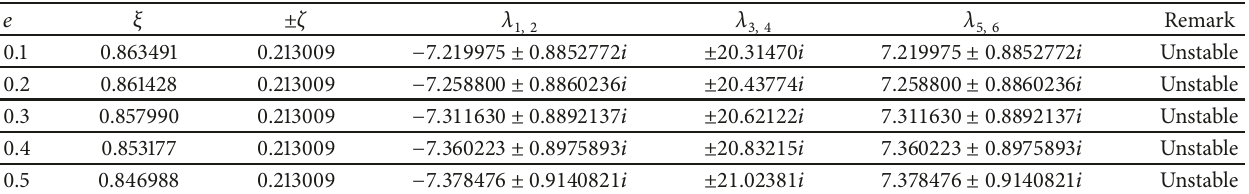
Table 6: Effects of eccentricity of DP-Leonis on the locations and stability of out-of-plane points for 𝑎 = 0.95, 𝐴 = 0.02, 𝜎 1 = 0.03 and 𝜎 2 = 0.015.